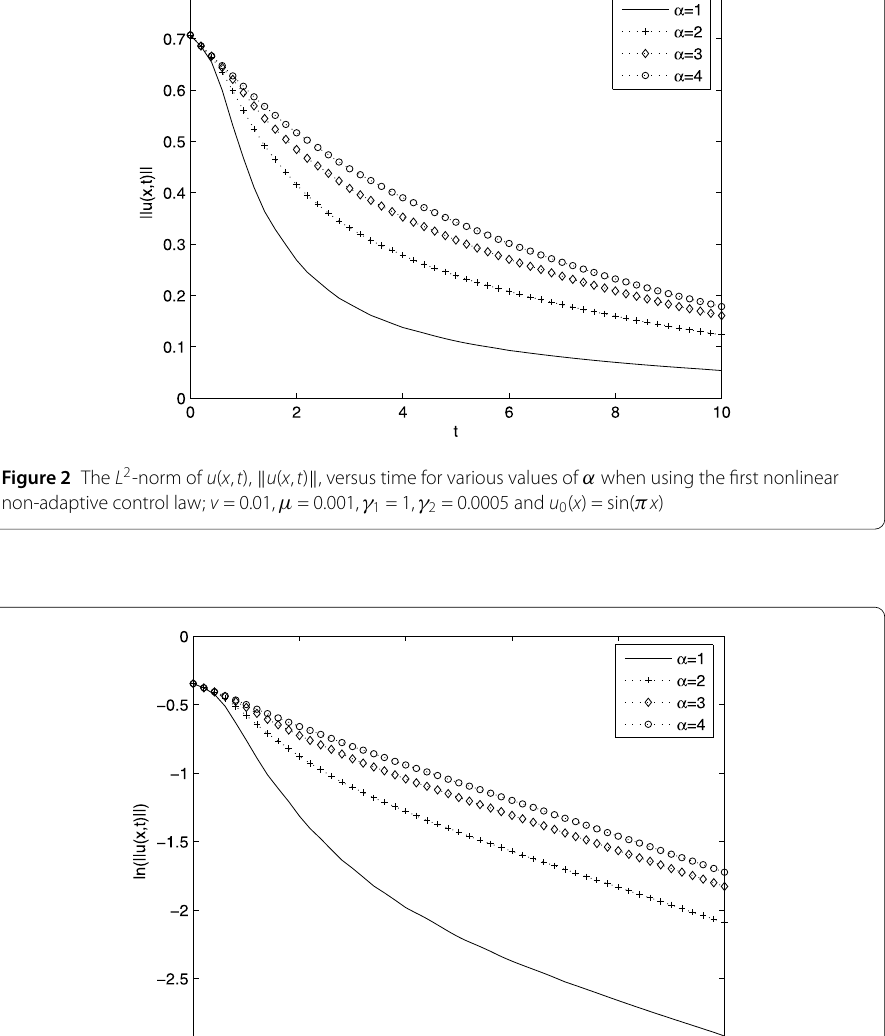
t = 5 seconds are presented by parallel lines with a negative slope less than – ν =